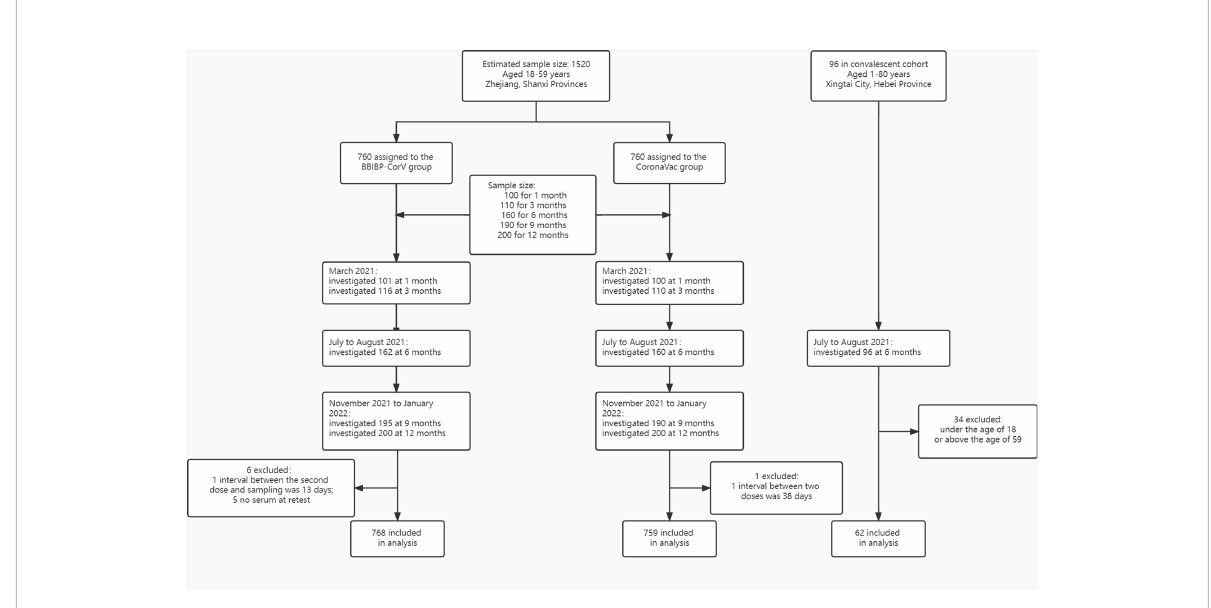
FIGURE 1 Study fl ow diagrams for participants by speci fi c